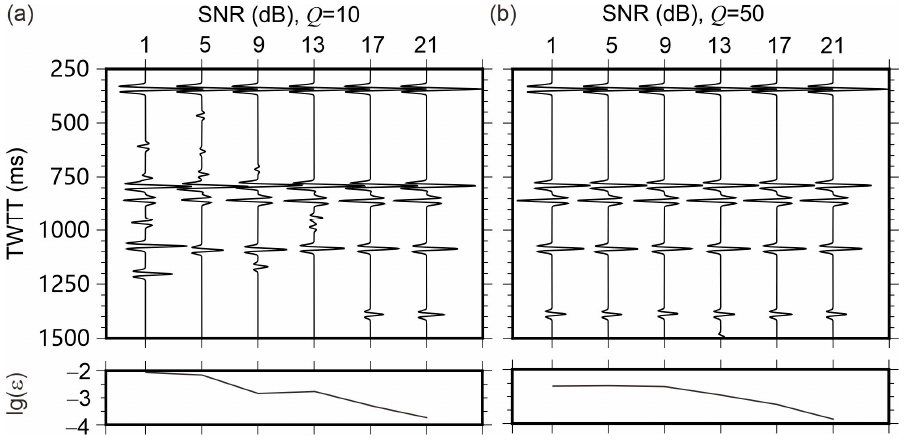
Figure 4. Seismograms obtained by ITD inversion of the data in Figure 3: ( a ) model with Q = 10, ( b ) Q = 50. The curve below each graph is the logarithm of the residual energy defined by Equation (12).